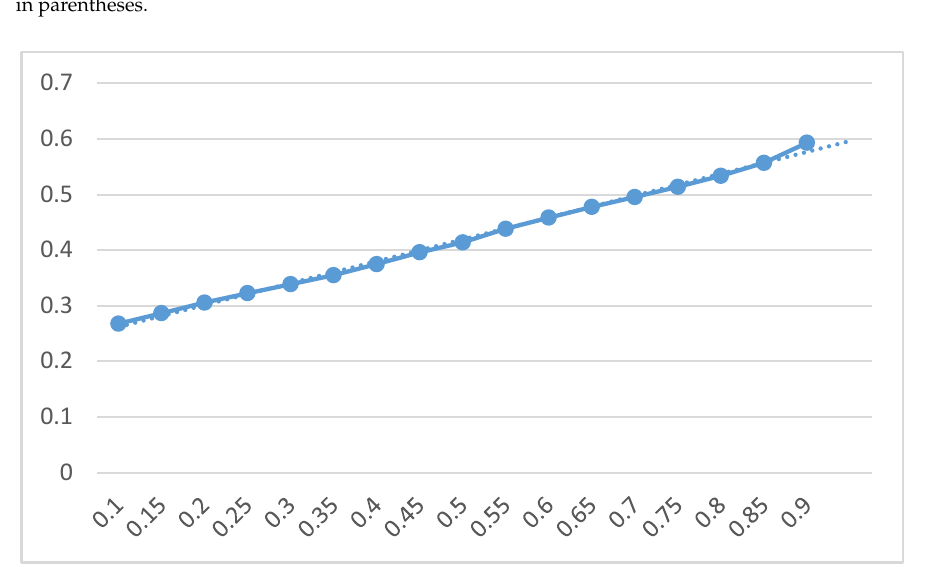
Figure 1. The regression coefficient diagram of the digital economy at each quantile.